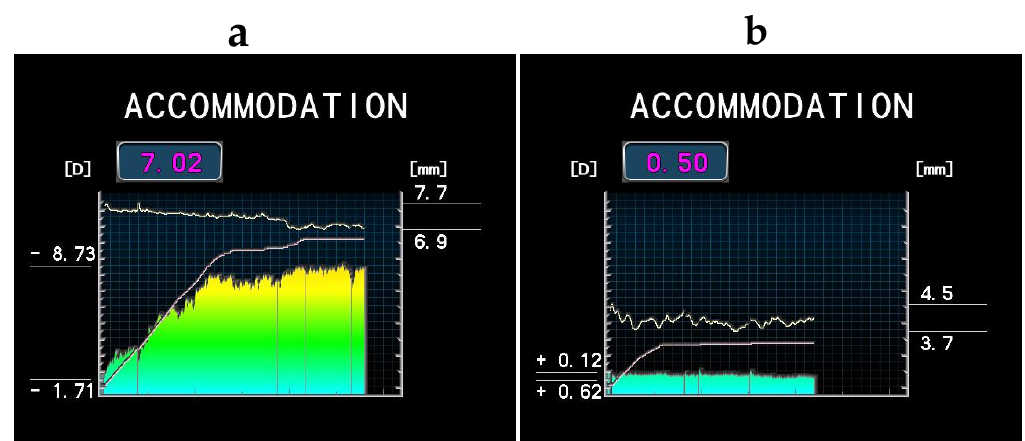
Figure 1. Representative results of the amplitude of accommodation (AA) and pupillary diameters measured by TONOREF III ® ; ( a ) 25 ‐ year ‐ old female, 7.02 D of AA; ( b ) 53 ‐ year ‐ old female, 0.50 D of AA. The X ‐ axis represents an examination time of up to 30 s. The left Y ‐ axis represents refraction, and the right Y ‐ axis represents the pupil diameter during measurement. The upper wave is a continuously recorded pupillary diameter. The colored bars represent the real ‐ time refraction, and the line chart represents the internal target position. The values on the left Y ‐ axis are the maximum and minimum refraction values, and the magnitude calculated as AA (D) is shown in the upper square. The minimum refraction value represents refraction when the visual target is located in the initial position. The values on the right Y ‐ axis are the maximum and minimum pupillary diameters.